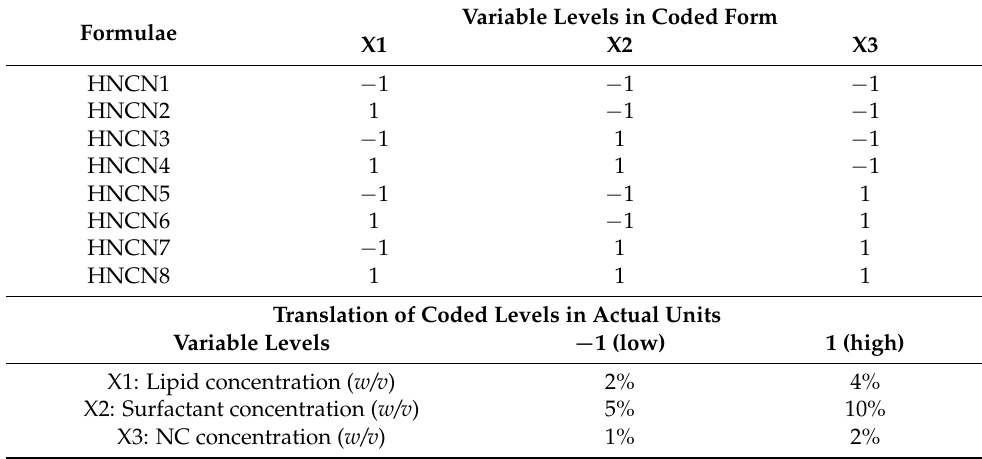
Table 3. Composition of the formulations based on 2 3 full-factorial design. Variable Levels in Coded Form Formulae X1 X2 X3 HNCN1